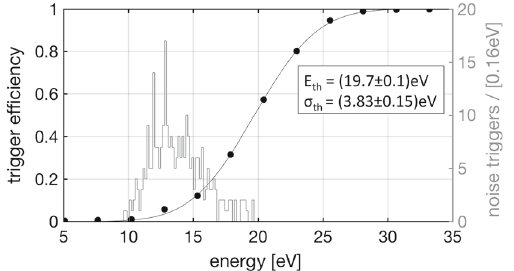
Fig. 4 Trigger efficiency evaluated at discrete energies (dots, left axis) by using the optimum trigger algorithm. These data points are fitted by an error function (solid line, see text). The histogram shows the distri- bution of the filter output (maximum) of randomly sampled noise traces (right axis). The energy threshold E th is chosen such that a negligible amount of noise triggers is accepted. Data from